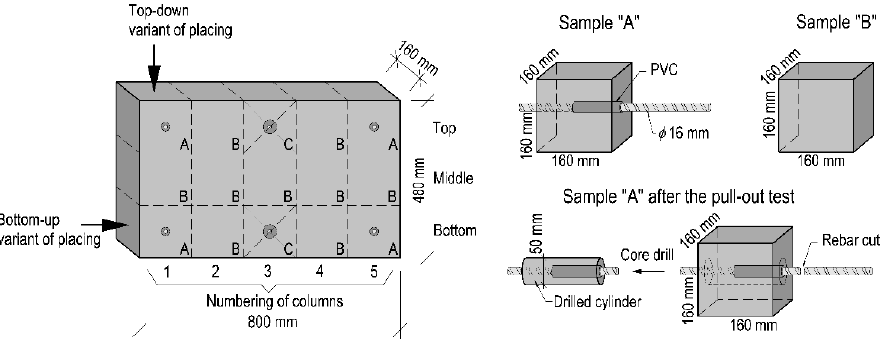
Figure 4. Schematic view of test panel elements and sample types.